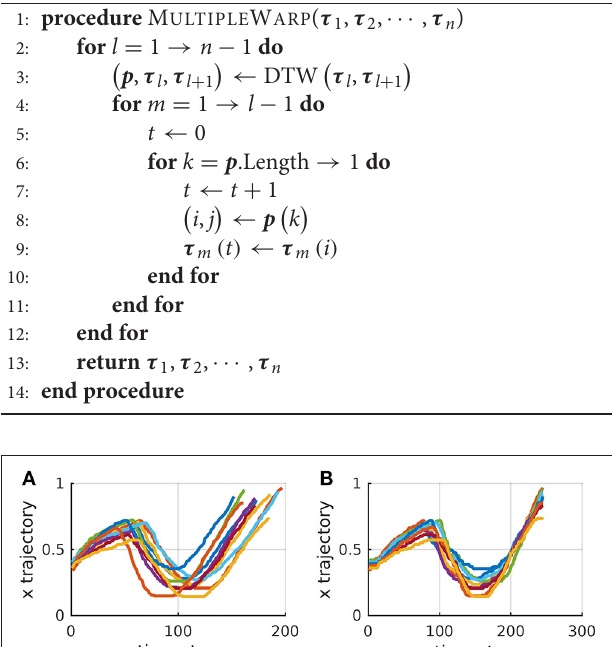
Algorithm 1 Path Search